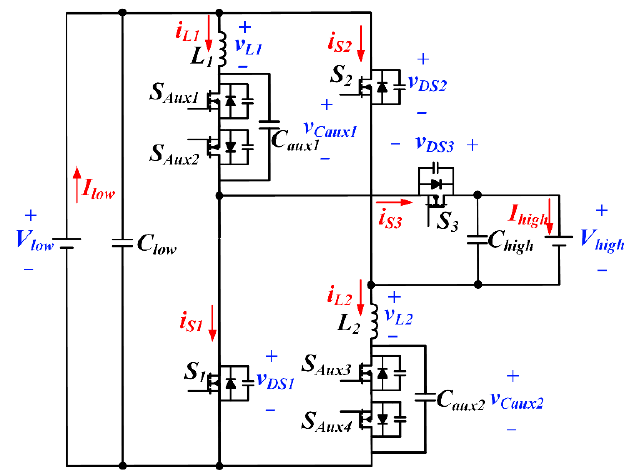
Figure 8. Circuit topology of the proposed bidirectional DC–DC converter.